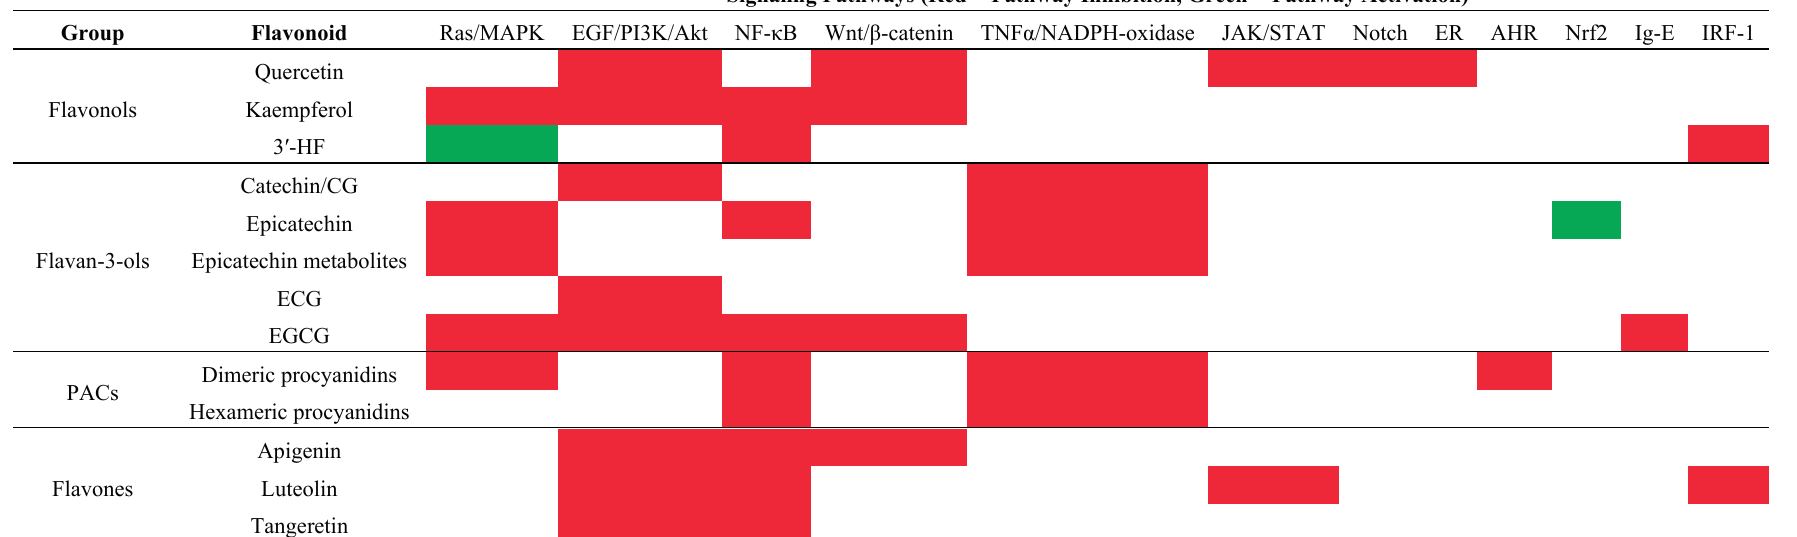
Table 2. Signaling effects of